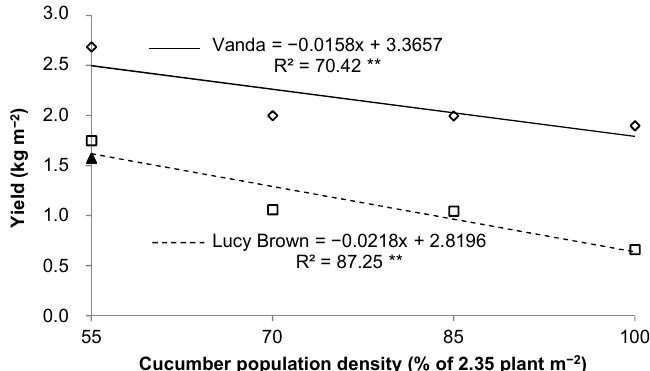
Figure 4. Total yield ( = commercial) of ‘Vanda’ and total and commercial yield of ‘Lucy Brown’ as a function of cucumber population densities. ◊ ‘Vanda’; □ ‘Lucy Brown’ Total; ▲ ‘Lucy Brown’ Commercial. ** p ≤ 0.01 in F test.